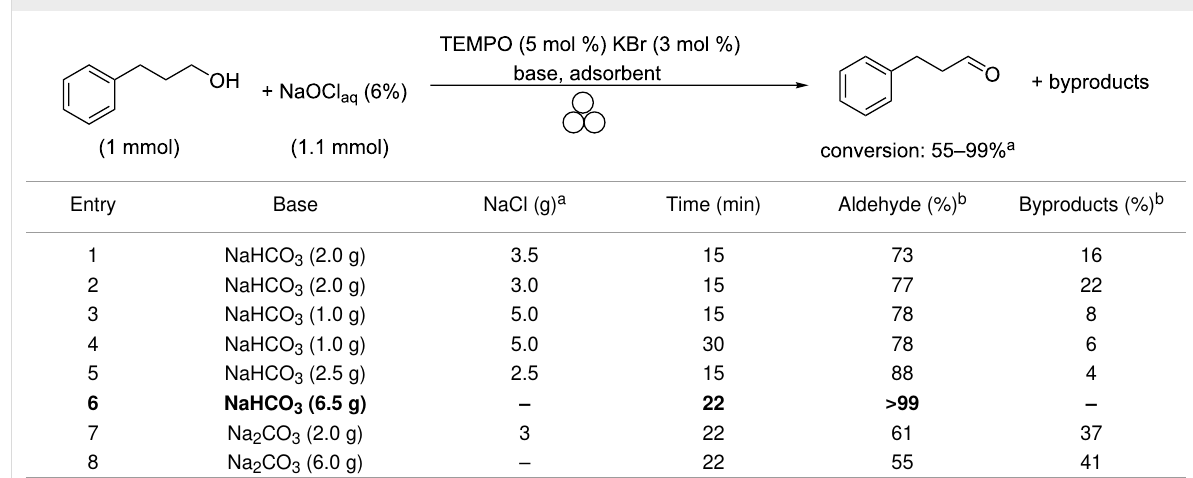
Table 1: Oxidation of 3-phenyl-1-propanol ( 1a ) with aqueous NaOCl (6%, bleach) under mechanical activation conditions